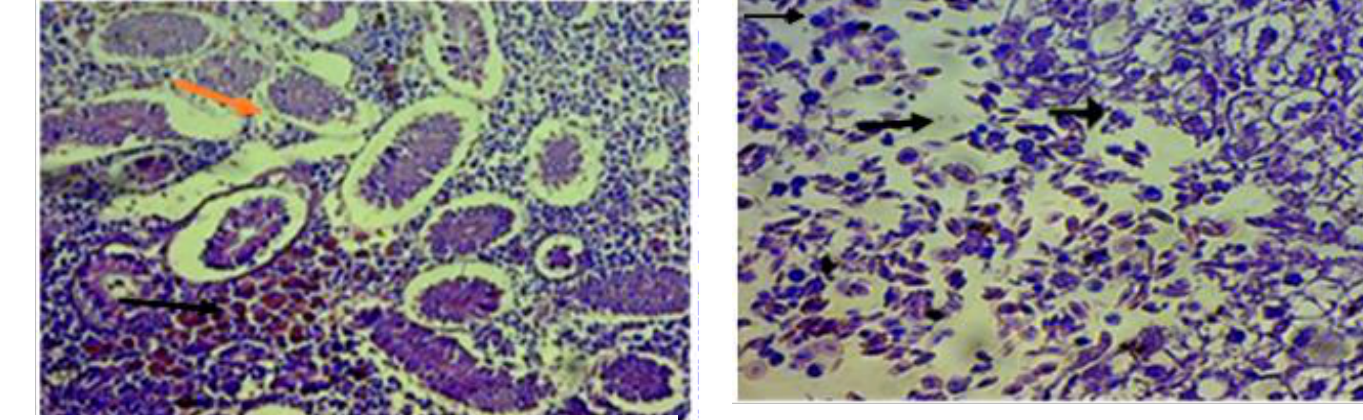
Figure 6. Histopathological section of liver shows severe destruction on hepatic parenchyma with oozing of blood and inflammatory cells into the necrotic area (